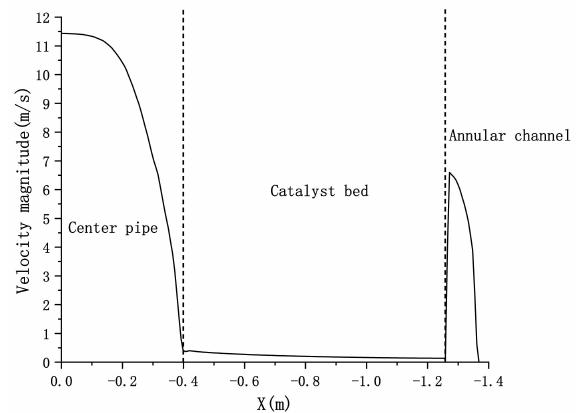
Figure 6. Velocity variation along the radius of the reactor at Y =